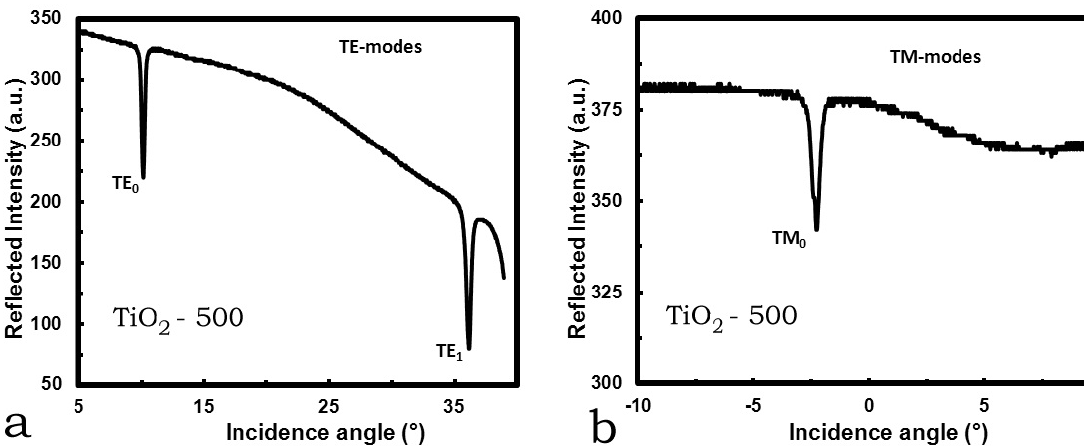
Figure 5. Typical guided mode spectra of TiO